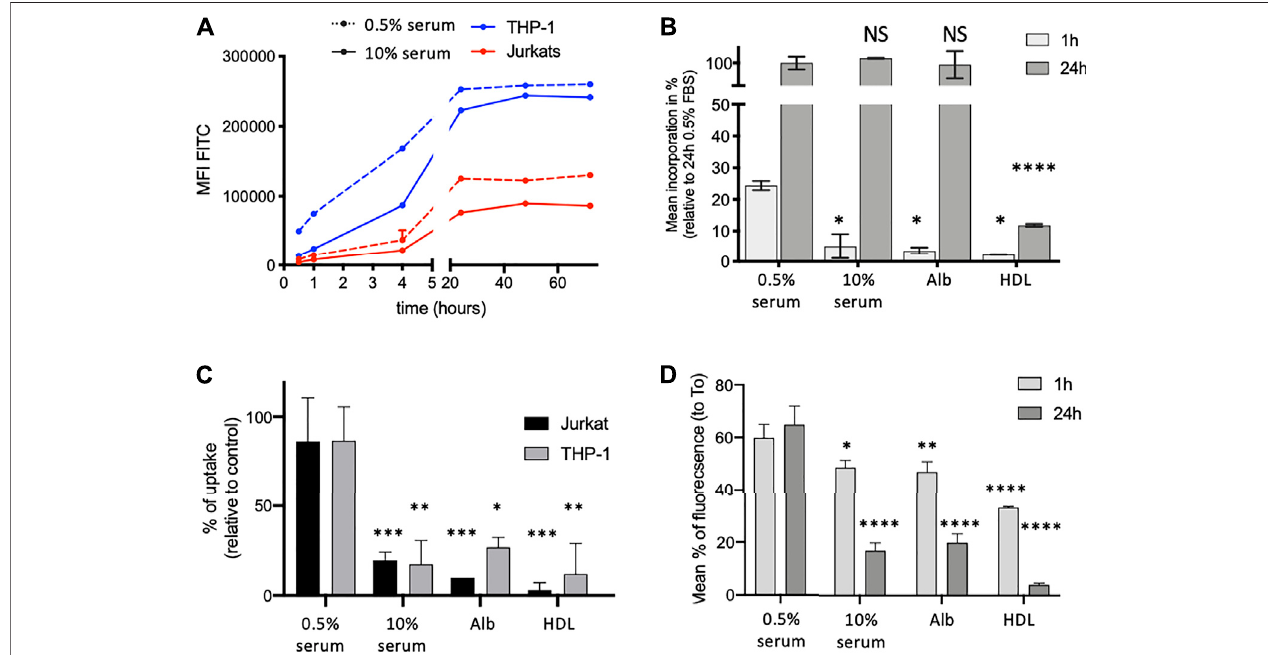
FIGURE2| SerumlipidcarriersdelayintracellulardiffusionofBdpy-ML. (A) Time-dependentincorporationofBdpy-ML(250 nM)asmeasuredby fl owcytometryin THP-1 (blue)andJurkatcells(red)cultured inmedium containing0.5%(dotted lines)or10%humanserum (plain lines).Dataaremean fl uorescencecorrectedbyFCSof duplicates ± SD and are representative of 3 independent experiments. (B) Incorporation of Bdpy-ML diluted in minimal medium (RPMI) ± 0.5% or 10% serum, 0.5% humanalbumin(Alb)or0.5 mg/mlhumanHDL,asmeasuredby fl owcytometryinTHP-1cellsafter1(lightgreybars)or24 h(darkgreybars)ofincubation.Dataare given as percentages of incorporation relative to maximum incorporation (24 h 0.5% serum) and are means of triplicates ± SD. (C) Uptake of natural mycolactone by Jurkat cells (black bars) and THP-1 cells (grey bars) after 1 h of incubation with mycolactone (75 ng/ml) in minimal medium (RPMI) ± 0.5% or 10% human serum, 0.5% human albumin (Alb) or 0.5 mg/ml human HDL. Data are expressed as mean percentages of uptake, estimated from a dose-dependent curve of inhibition of IL-2 and TNF- α respectively. Means of duplicates ± SD. (D) Intracellular contain of Bdpy-ML in THP-1 cells loaded with Bdpy-ML (T0) then washed and incubated 1 or 24 h